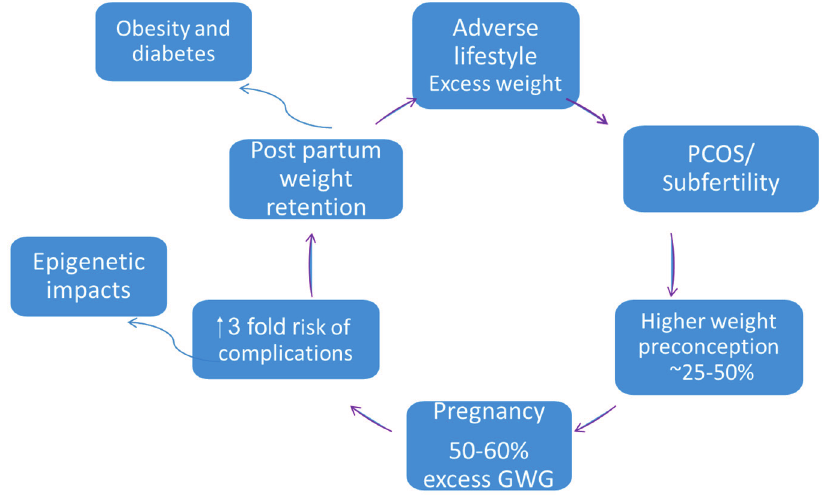
Figure 1. The vicious cycle of obesity and reproductive complications. Women with adverse lifestyle factors and excess weight are more likely to develop polycystic ovarian syndrome (PCOS) and subfertility. They are likely to enter pregnancy overweight and are at increased risk for excess gestational weight gain (GWG). Obesity and excess GWG results in a three-fold increased risk of adverse pregnancy outcomes including gestational diabetes mellitus (GDM), and may have epigenetic impacts including long term metabolic syndrome and cardiovascular disease for mother and baby. Post-partum weight retention contributes to prevalent obesity and type 2 diabetes mellitus (T2DM) long-term and to risks in subsequent pregnancies